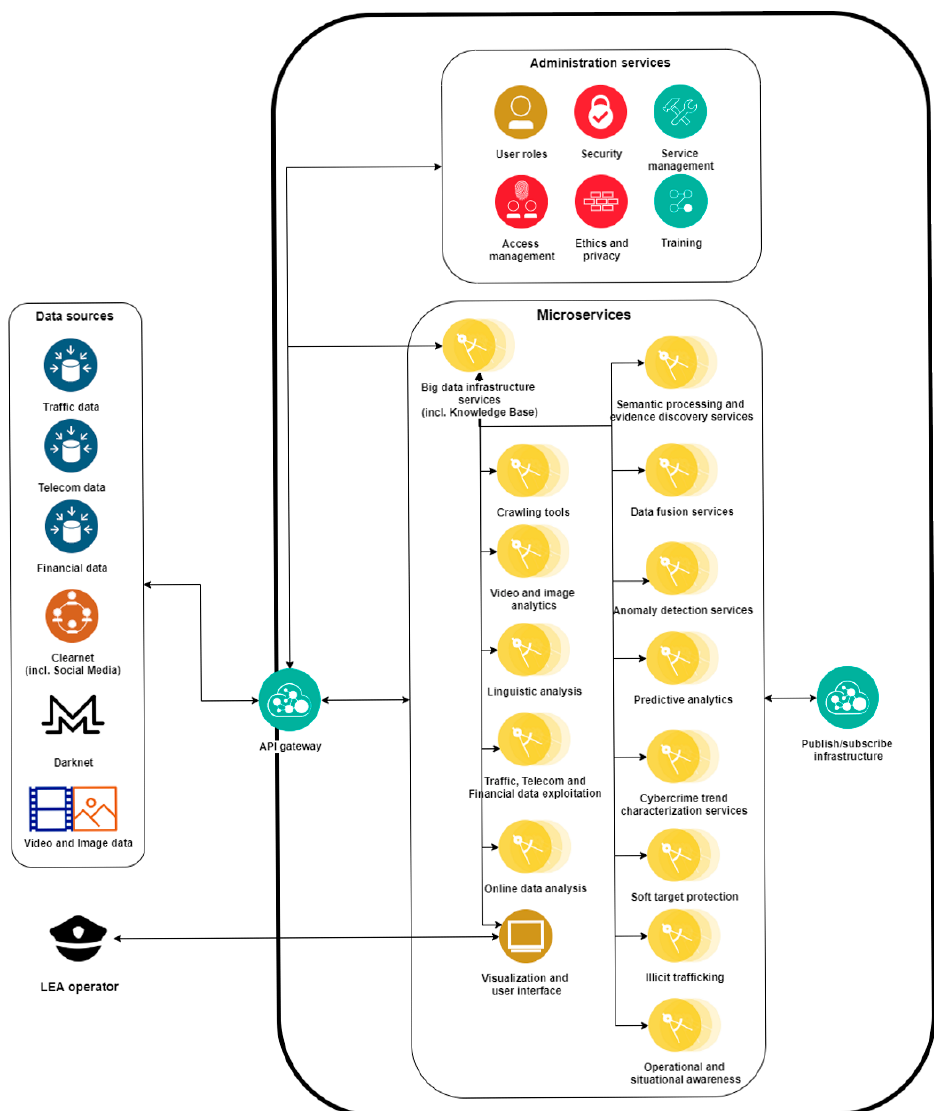
Figure 1. High level